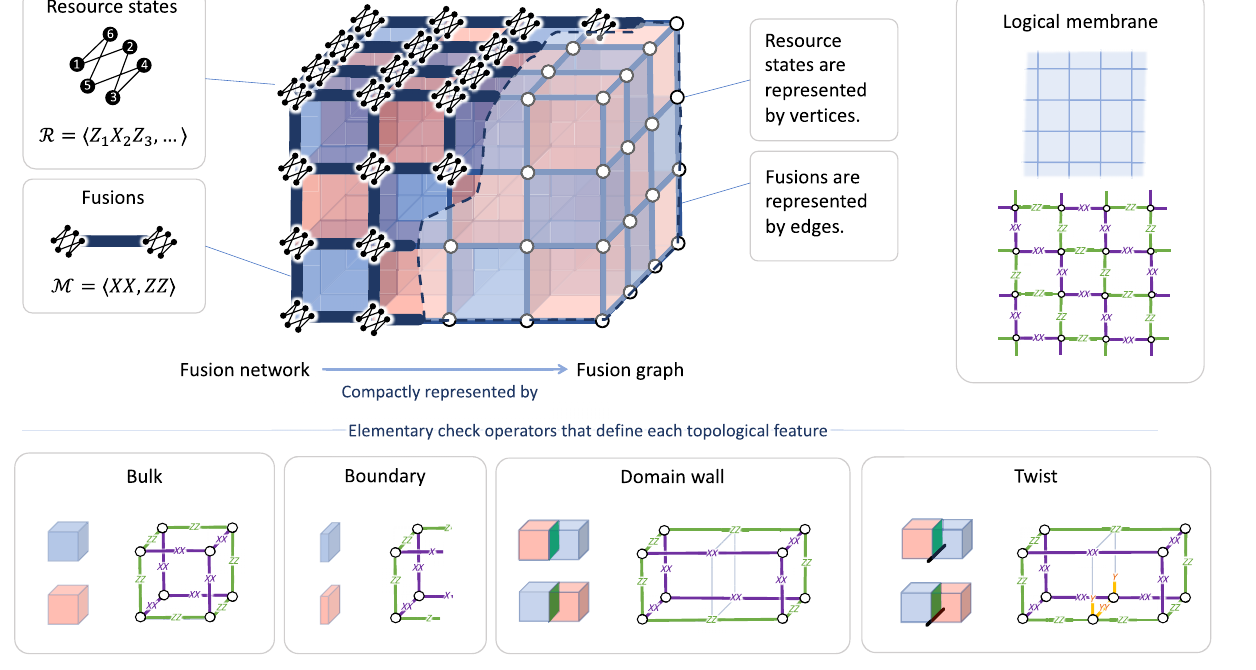
FIG. 11. The six-ring fusion network. The fusion network can be compactly represented by a fusion graph—a cubic graph whose vertices represent resource states (six-ring cluster states) and whose edges represent fusions. Logical membranes and check operators for various features are